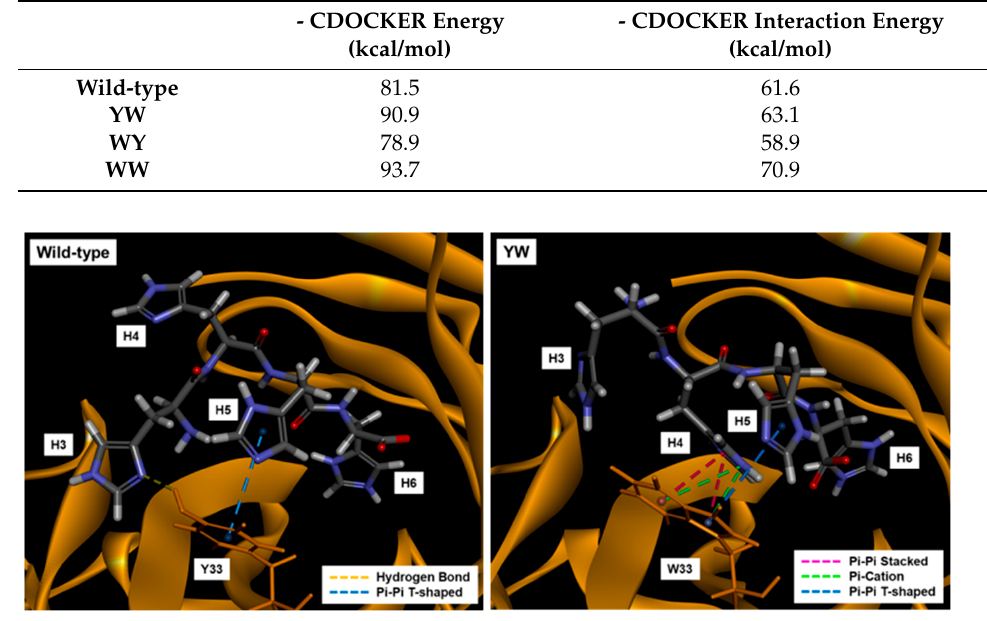
Figure 8. Docking poses of the wild-type and YW mutant.